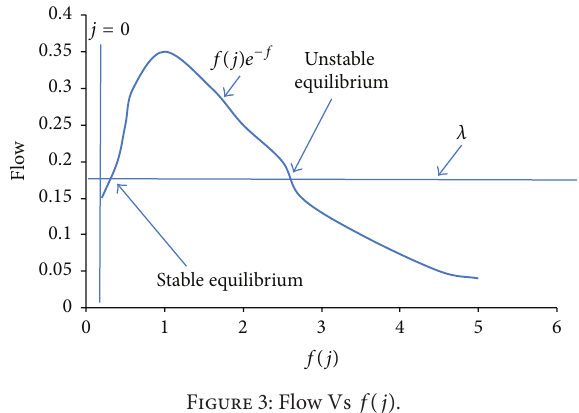
Figure 3: Flow Vs 𝑓(𝑗)